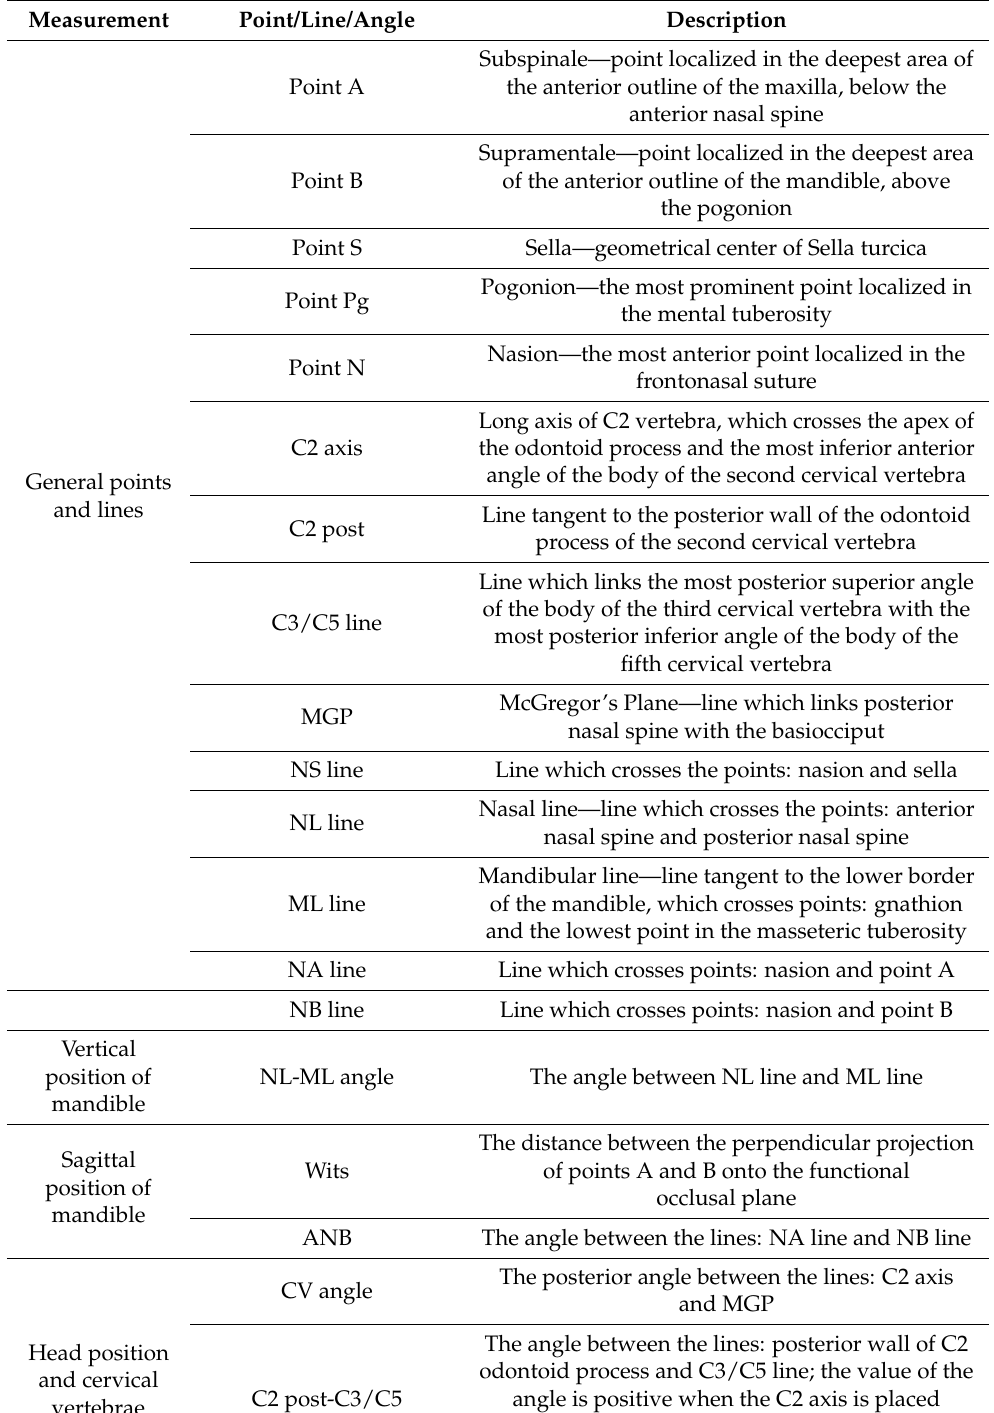
Table 1. Reference points, lines, and angles used in cephalometric analysis to assess the changes in cervicofacial skeleton after occlusal splint therapy combined with physiotherapy in patients diagnosed with temporomandibular joint disorders